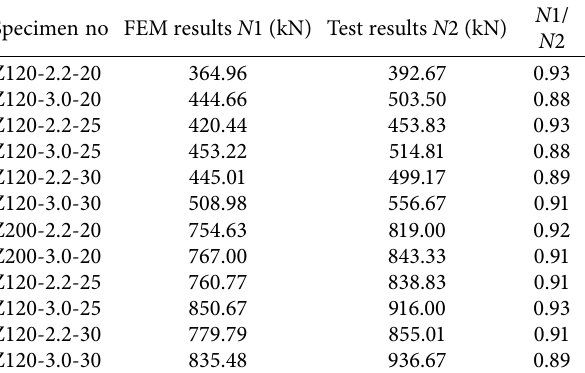
Figure 17: Equivalent plastic strain cloud of core concrete in the specimen Z2000-2.2-20. Table 8: Comparison of ultimate bearing